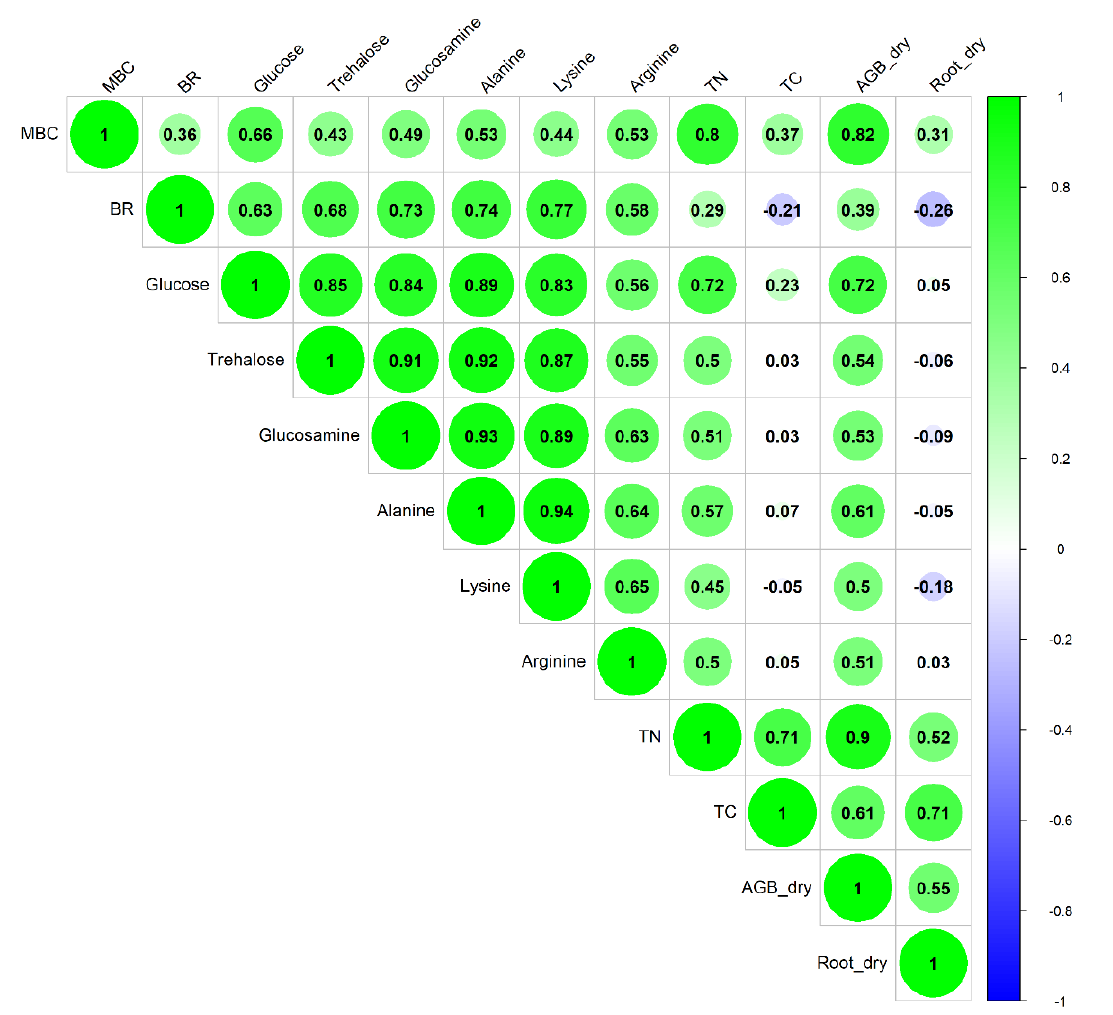
Figure A1. Correlation Matrix of Soil Properties (numbers indicate the Pearson’s correlation coefficient).